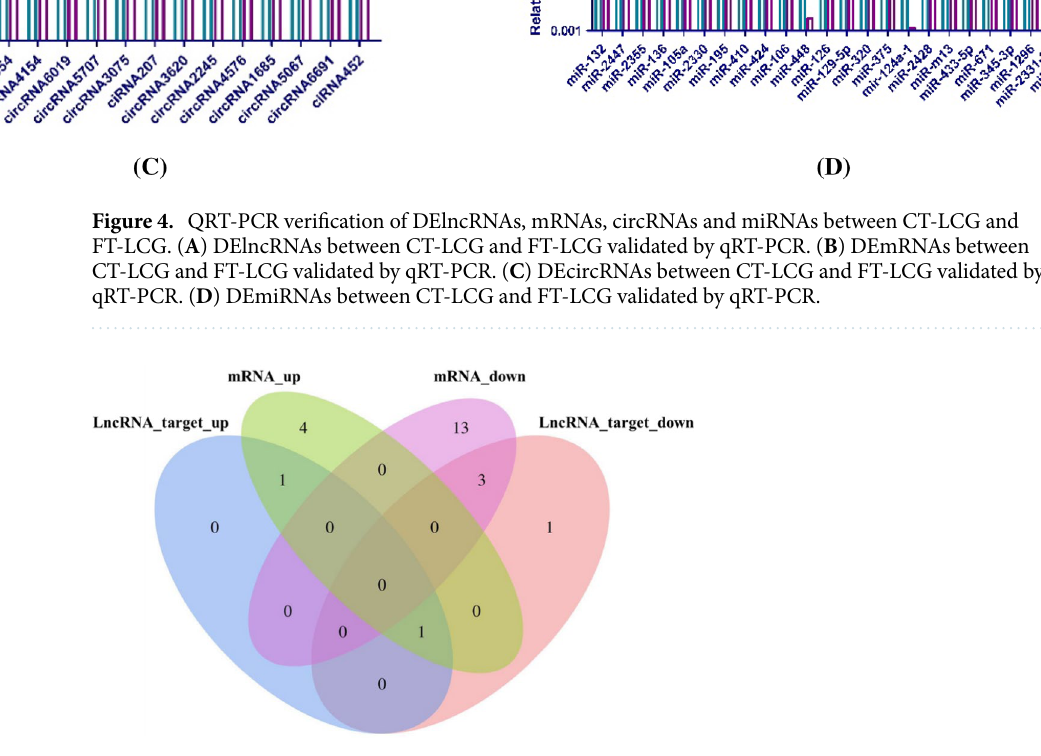
Figure 5. Veen gram showing the Integrative analysis of lncRNA targets and